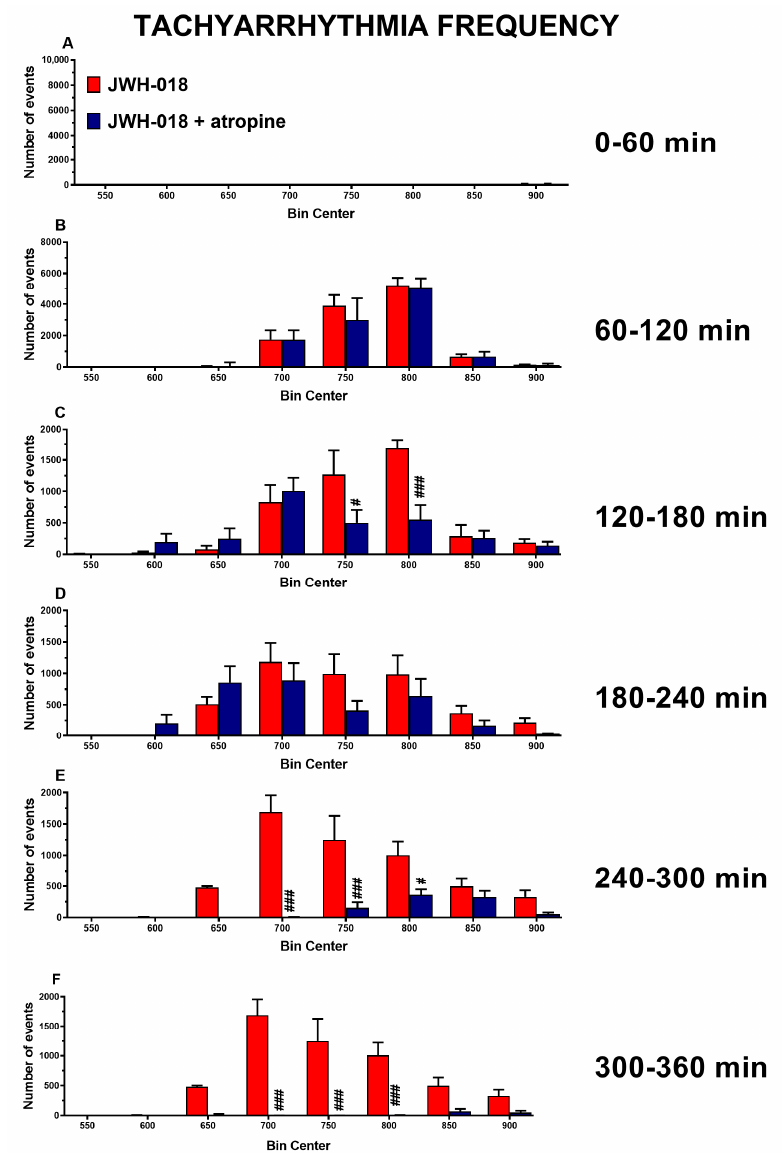
Figure 4. Frequency of tachyarrhythmia episodes between 0–60 ( A ), 60–120 ( B ), 120–180 ( C ), 180–240 ( D ), 240–300 ( E ), and 300–360 ( F ) minutes after administration of JWH-018 (6 mg/kg) or JWH-018 followed by atropine (5 mg/kg), expressed as number of events per mean heart rate value. Mean ± SEM of eight different evaluations for each group. Statistical analysis was performed by two-way ANOVA followed by Bonferroni’s test for multiple comparisons. # p < 0.05, ### p < 0.001 versus JWH-018 + atropine.